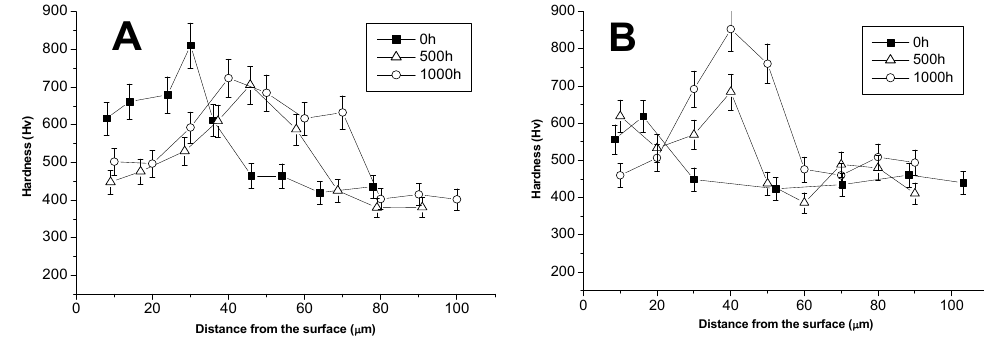
Figure 5. Hardness profile measurement for IN738 + Pack aluminizing + Post treatment ( A ) and IN738 + IL aluminizing + post treatment ( B ), respectively, at 0, 500 and 1000 h of isothermal test (1000 °C).